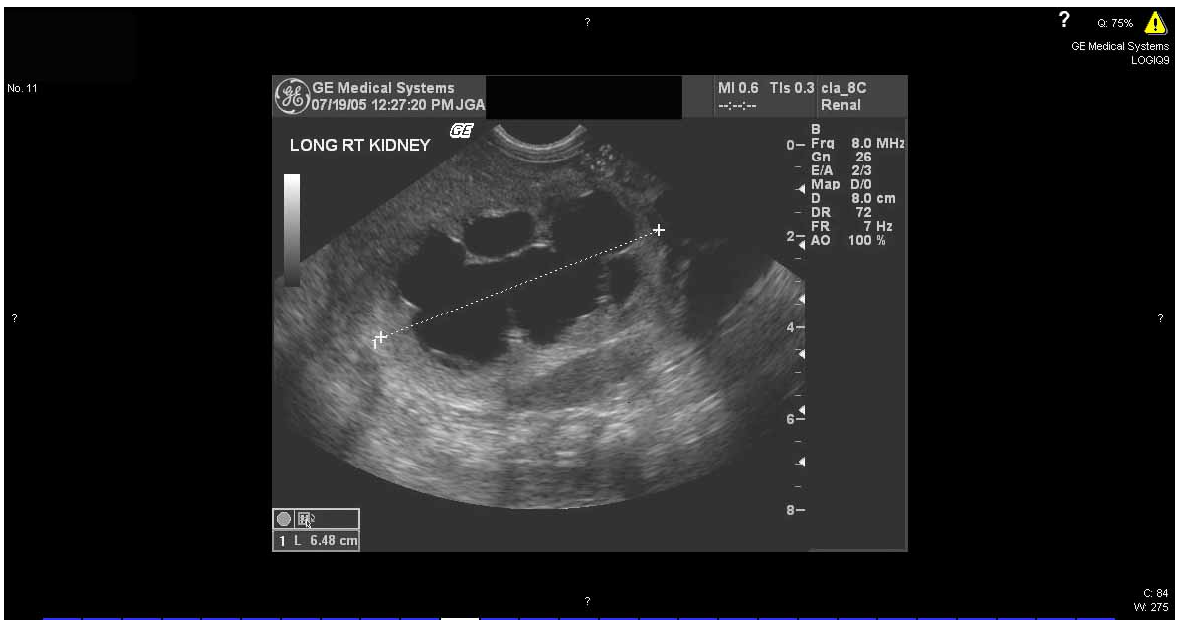
FIGURE 6B . Renal ultrasound demonstrating grade 4 hydroureteronephrosis secondary in a patient with posterior urethral